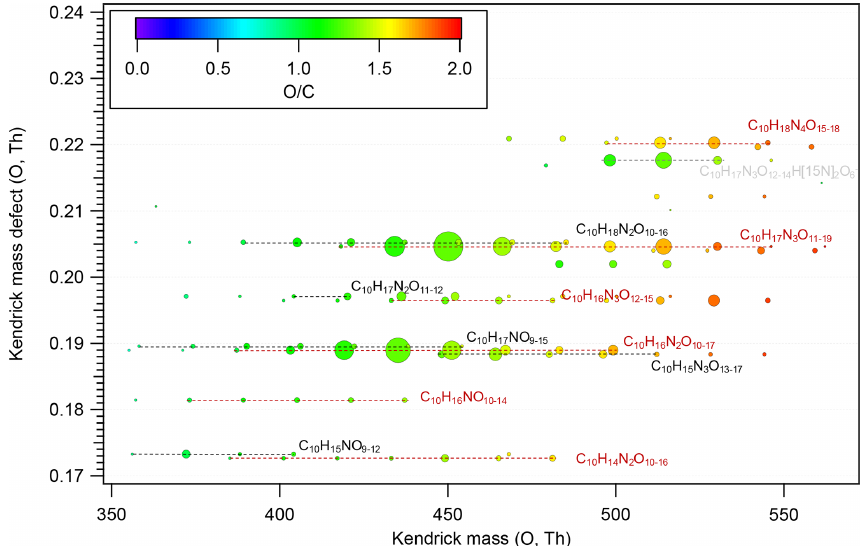
Figure 4. Kendrick mass defect plot for O of HOM dimers formed in the isoprene + NO 3 reaction. The size (area) of circles is set to be proportional to the average peak intensity of each molecular formula during the first isoprene addition period (P1). The molecular formula includes the reagent ion 15 NO − , which is not shown for simplicity. The species labeled in grey (C 10 H 17 N 3 O 12–14 H[15N] 2 O − 3 adducts of C 10 H 17 N 3 O 12–14 with H[15N] 2 O − 6